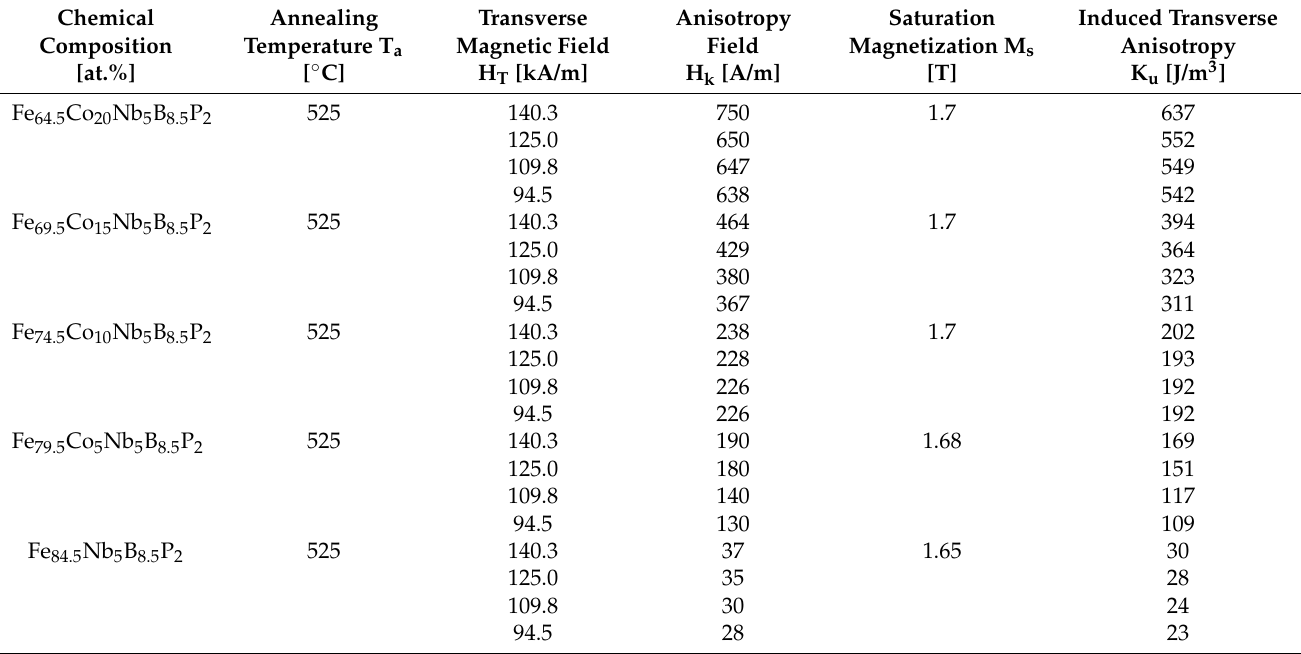
Table 3. The influence of the transverse magnetic field H T present during annealing on the anisotropy field H k and